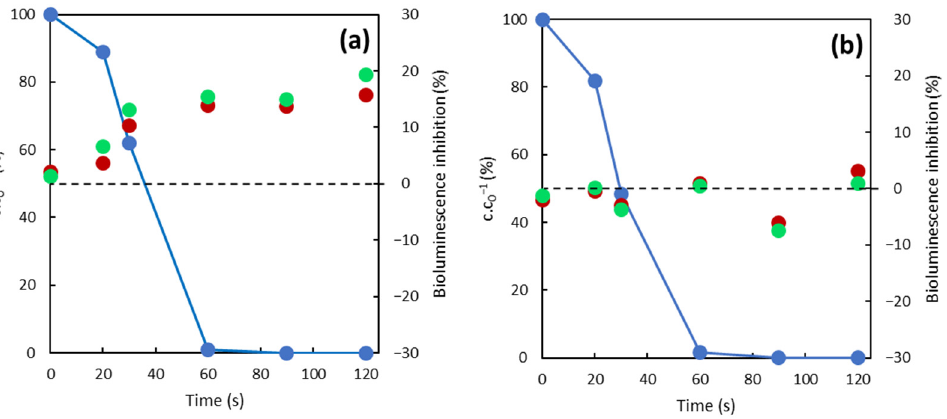
Figure 5. Time dependence of DCF over time (left axis—normalized concentration DCF (%); right axis—inhibition of bioluminescence ● after 15 min and ● after 30 min). ( a ) Photolytic reactions; ( b ) photocatalytic reactions.